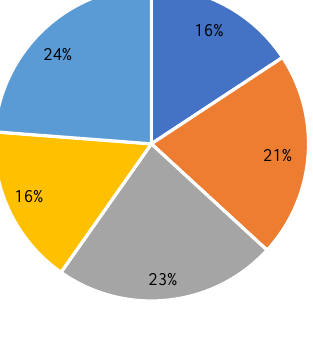
Figure 5. Characteristics of the respondents in terms of using a mobile phone when crossing a pedestrian crossing.